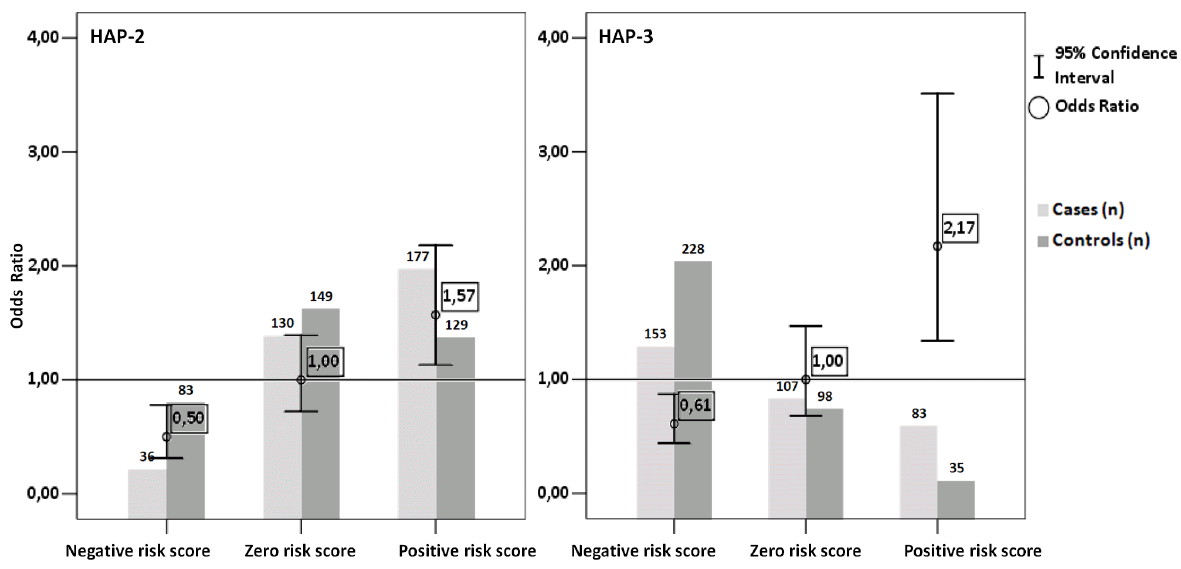
Figure 2. Association of haplotype combination from CETP gene with the presence of low HDL-C level. Negative risk score represents individuals with one or two ‘‘protective’’ haplotypes; zero risk score represents individuals with ‘‘neutral’’ haplotypes or one ‘‘protective’’ and one ‘‘risk’’ haplotype, Positive risk score represents individuals with one or two ‘‘risk’’ haplotypes. Subjects with zero risk score were used as reference group. Light grey columns indicate number of individuals with low HDL-C levels; dark grey columns indicate number of individuals with high HDL-C levels. Error bars represent confidence intervals at 95%.